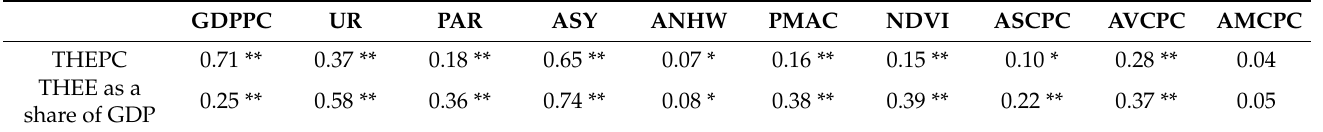
Table 2. The estimated explanatory powers of the selected 10 variables on the THEPC and the THEE’s GDP share by the GeoDetector model. GDPPC UR PAR ASY ANHW PMAC NDVI